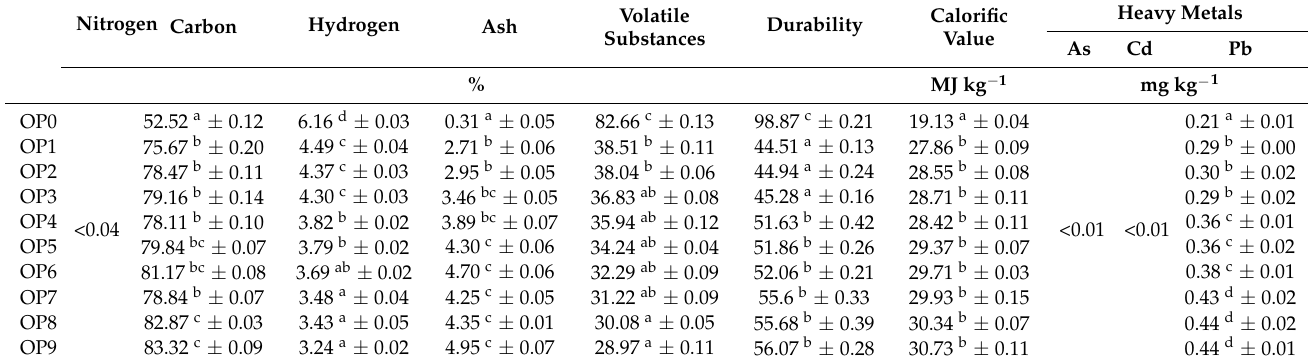
Table 5. The content of general nitrogen, total carbon, hydrogen, ash, volatile substances, heavy metals and durability, calorific value of coniferous and deciduous pellets and